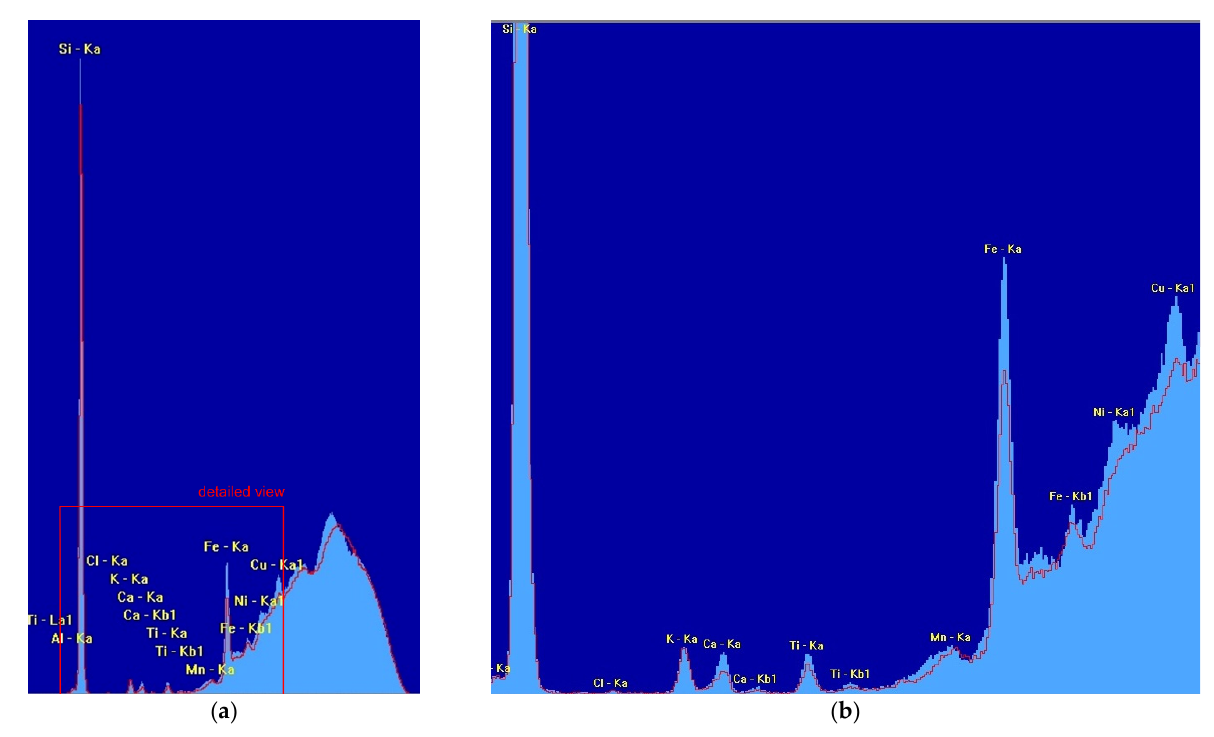
Figure 6. Output of spectroscopic elemental isotope analysis of kinetic sand. Red line represents the original sand. Light blue area represents the boiled sand. Si-silicon, Al-aluminum, K-potassium, Fe-iron, Ca-calcium, Ti-titanium, Ni-nickel, Mn-manganese, Cu-copper, Cl-chlorine. ( a ) Overall view; ( b ) Detailed view. Ka, Ka1, Kb1, La1 - description of X-rays corresponding to the transition energy between different energy levels of atom (Ka, Ka1 - transition from L level to K level, Kb1 - from M to K, La1 - from M to L).